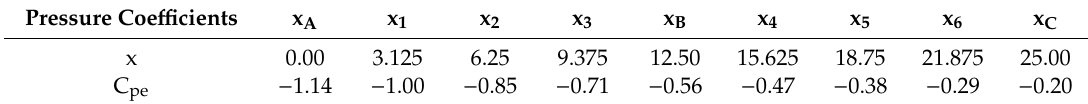
Table 6. Interpolated values of wind pressure coefficients.